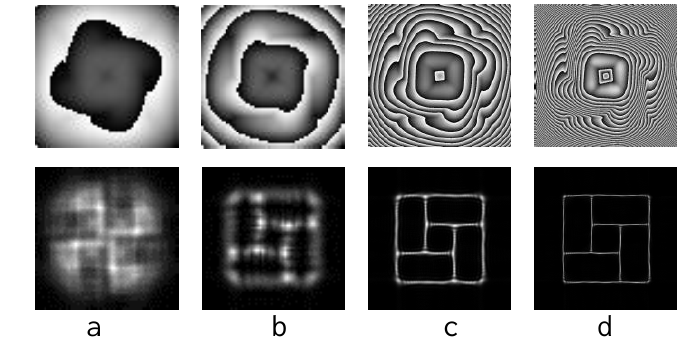
Figure 2. Rectangular holographic masks ( top ) and their simulation diffraction pattern ( bottom ) with different f values, where, ( a , b ) with f = 5 cm and f = 2cm, and ( c , d ) for an expansion mask with f = 5 cm and f = 2cm, respectively.